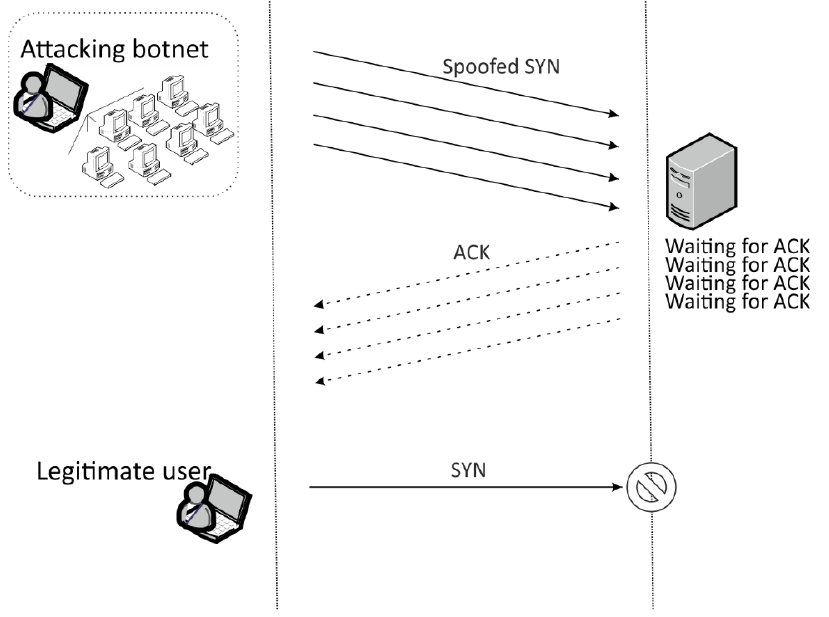
Figure 2. SYN flood Distributed Denial of Service (DDoS) attack.